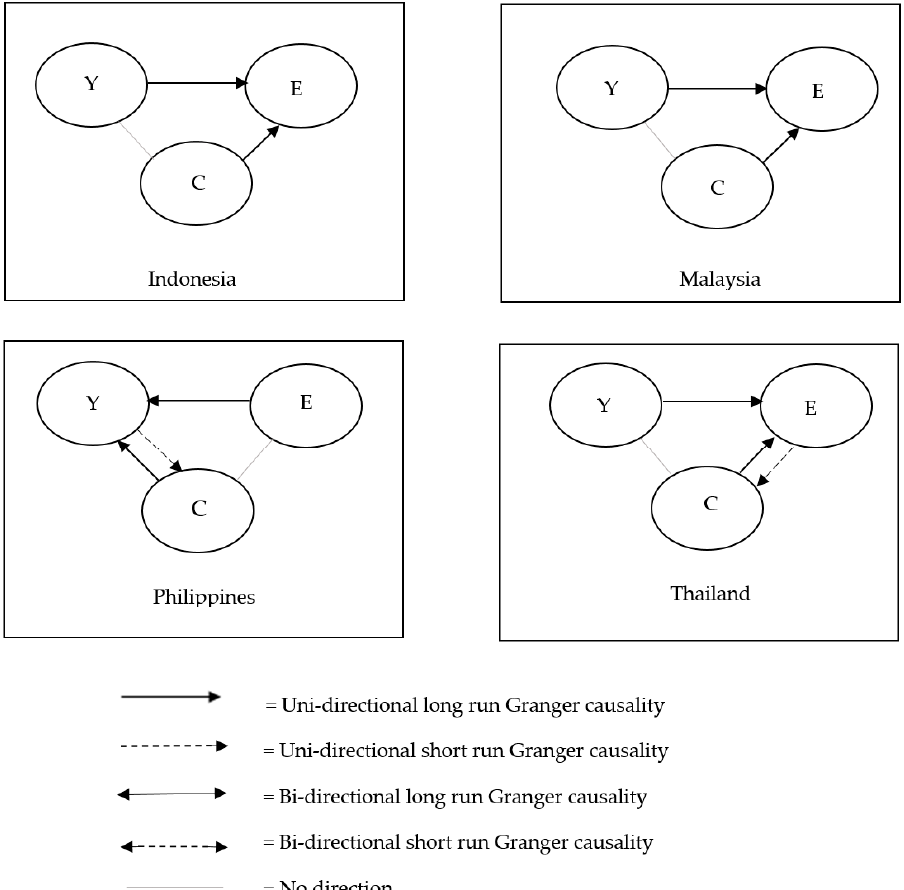
Figure 2. Granger causality relationship flows.